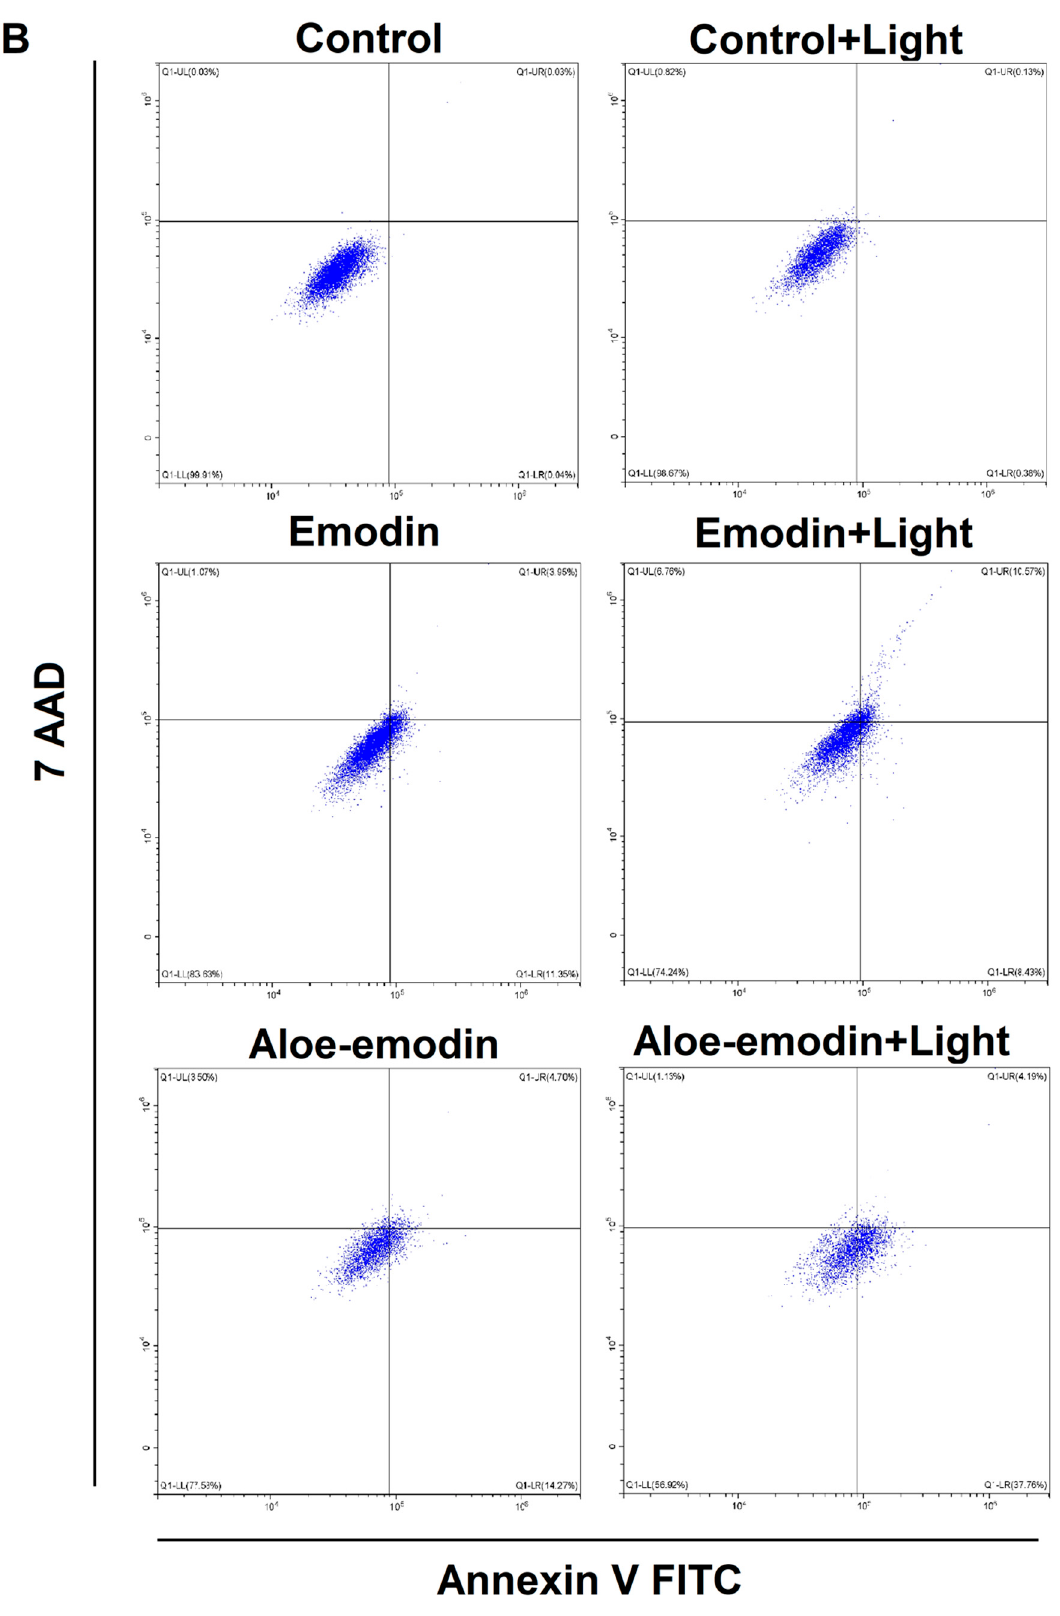
Figure 6. Effect of photodynamic therapy (PDT) with emodin or aloe-emodin in dose 20 μ M with the blue light (6 J/cm 2 ) in SCC-25 ( A ); MUG-Mel2 ( B ) cells. After treatment, the cells were stained using Annexin-FITC/7-AAD Kit and were measured by flow cytometry.